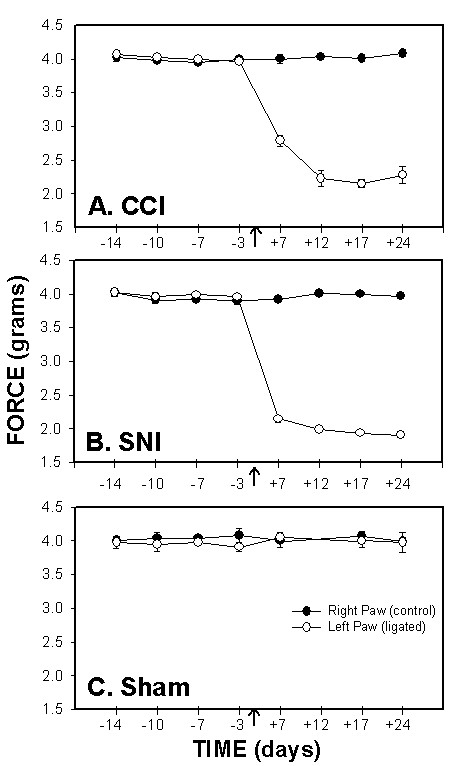
Mechanical sensitivity, force (g) required for 50% threshold for paw withdrawal, as a function of time in CCI (A), SNI (B) and sham (C) rats. Mechanical paw-withdrawal thresholds of the ligated paw were significantly attenuated after ligation (indicated by an arrow) in the CCI and SNI models as compared to the right paw (control), and to sham. In both groups, increased mechanical sensitivity persisted for 24 days after ligation.